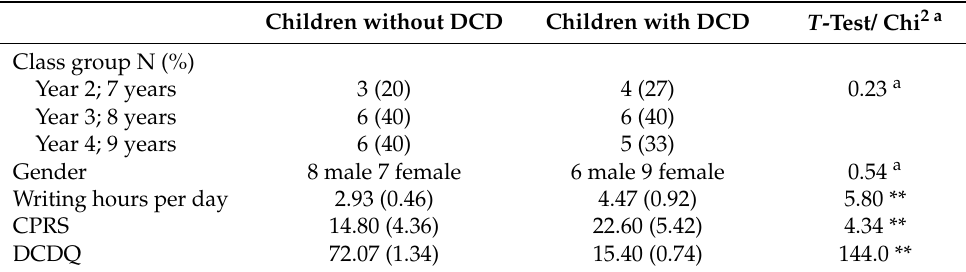
Figure 2. Allocation sequence and participant flow. Table 1. Participant characteristics ( n = 30). Data of writing per hour, CPRS, and DCDQ scores are presented as means and standard deviation in parentheses.